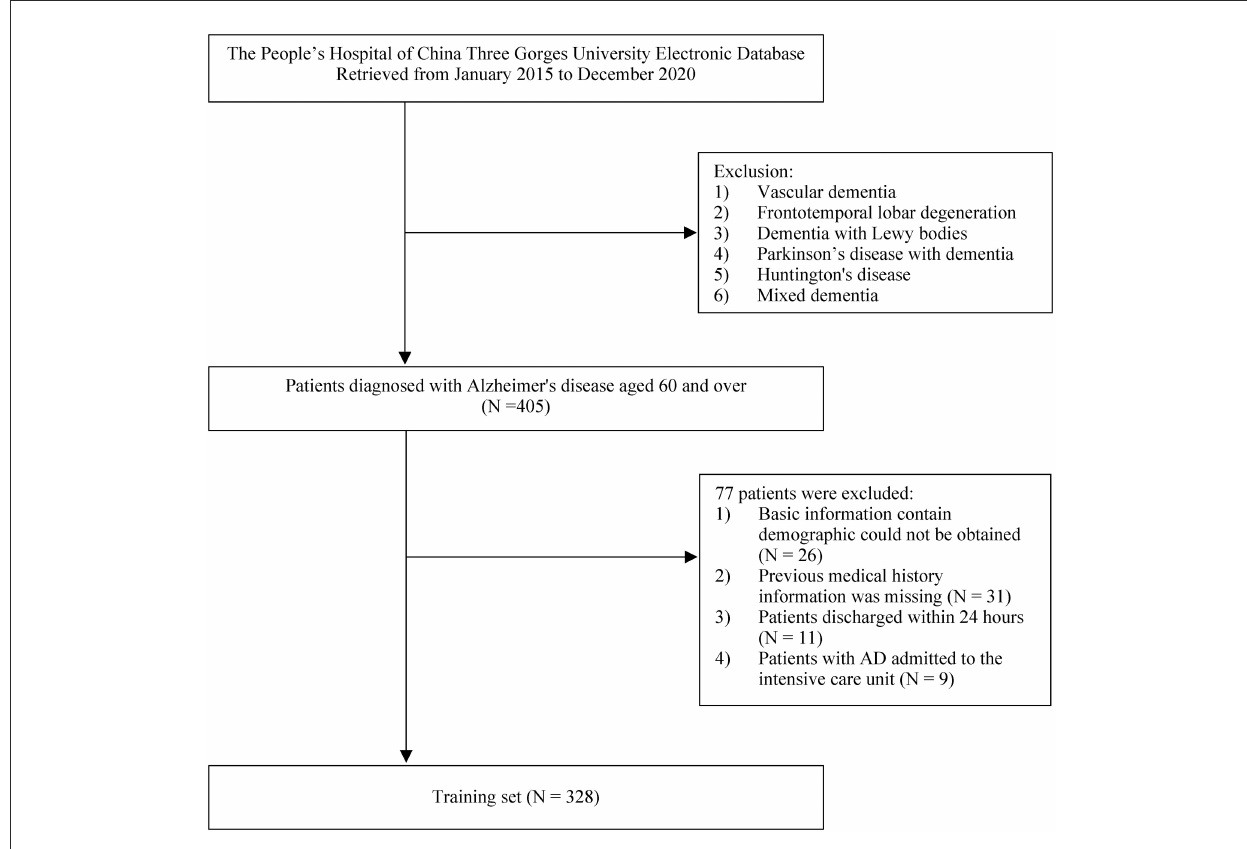
FIGURE1 Flow diagram of the selection of eligible